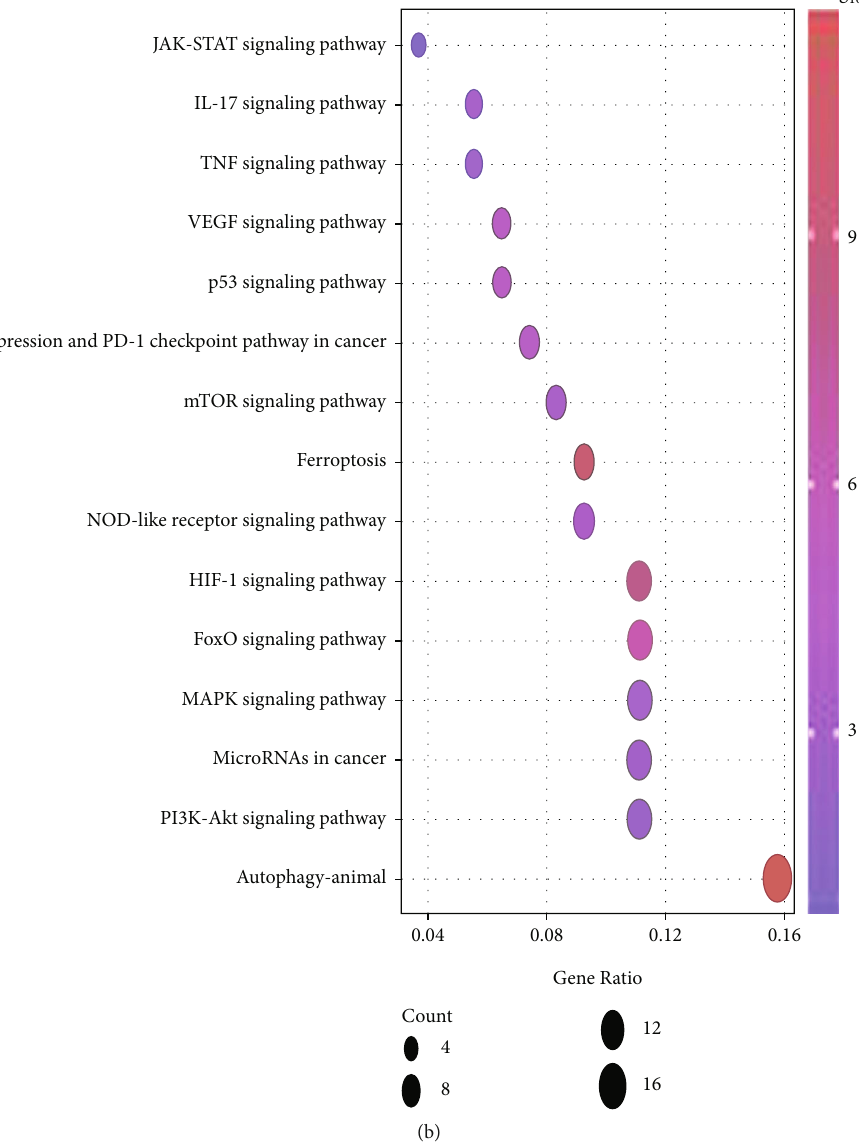
Figure 1: GO and KEGG analyses of di ff erentially expressed genes related to ferroptosis. (a) GO analysis results. The color of the dots represents the adjusted P value: red, low; blue, high. The size of the dots represents the number of ferroptosis-related genes. (b) KEGG pathway enrichment analyses. The color of the dots represents the adjusted P value, and the size of the dots represents the number of ferroptosis-related genes in the pathway. GO: Gene Ontology; KEGG: Kyoto Encyclopedia of Genes and Genomes; BP: biological process; CC: cellular component; MF: molecular